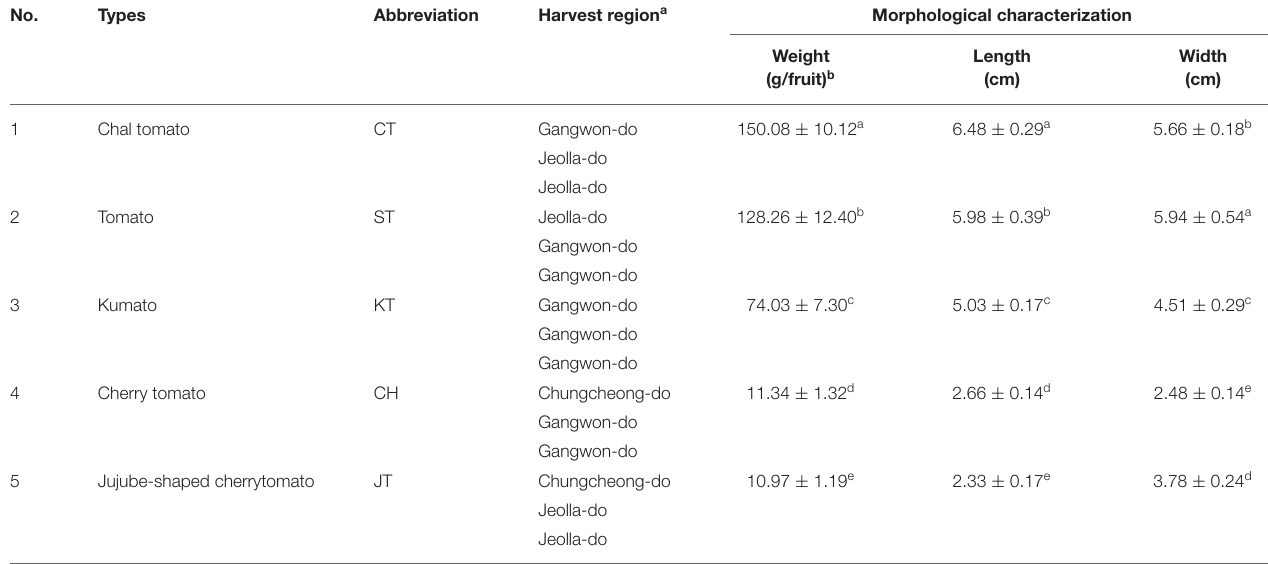
TABLE 1 | Information of five types of tomato samples and morphological